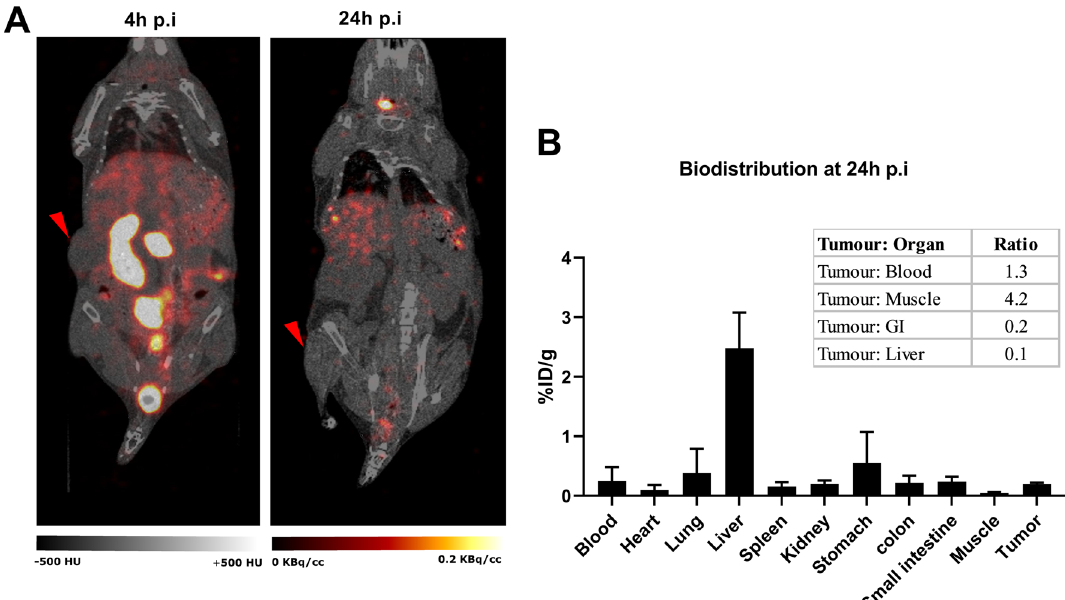
Fig. 2 A Representative SPECT/CT images of biodistribution obtained at 4 h (left) and 24 h (right) post injection. Red arrow shows tumour location. B Ex vivo biodistribution of [ 123 I]PARPi-01 at 24 h p.i in NOD/SCID mice bearing- subcutaneous MDA-MB-231 xenograft ( n